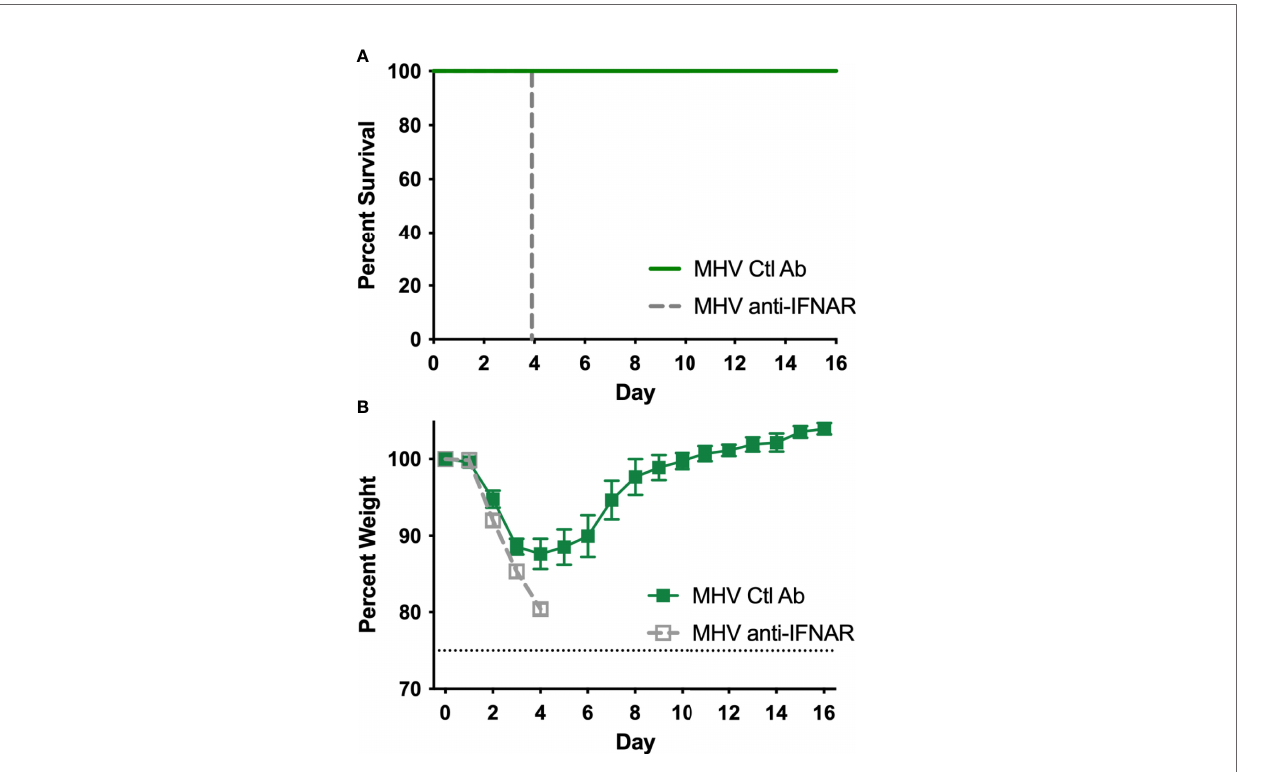
FIGURE 4 | Signaling through the type I IFN receptor, IFNAR, is required for survival of sublethal MHV-1 infection. Mice (n=5 per group) were inoculated intranasally with MHV-1 (1x10 3 PFU) and 0.05 mg of anti-IFNAR1 or control (Ctl) antibody on day 0. A second dose of antibody was given on day 2. (A) Mortality ( p =0.0027) and (B) weight loss were monitored